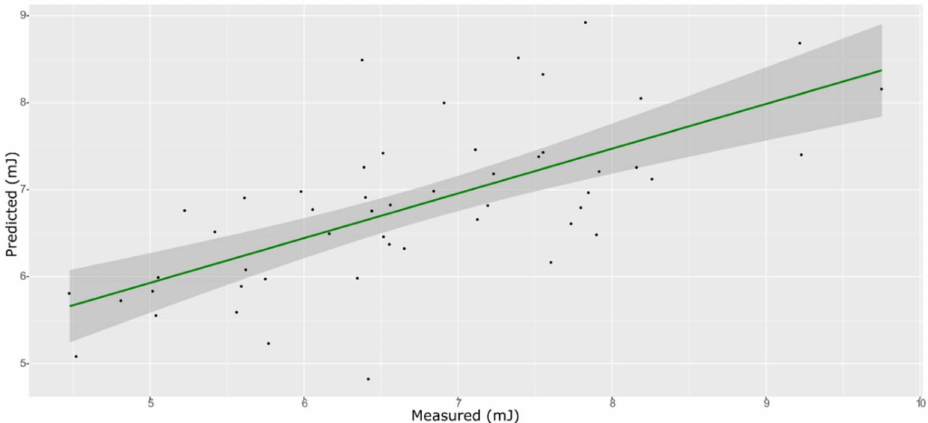
Figure 15. PLS model for BCh on the test set, using the selected wavenumbers.